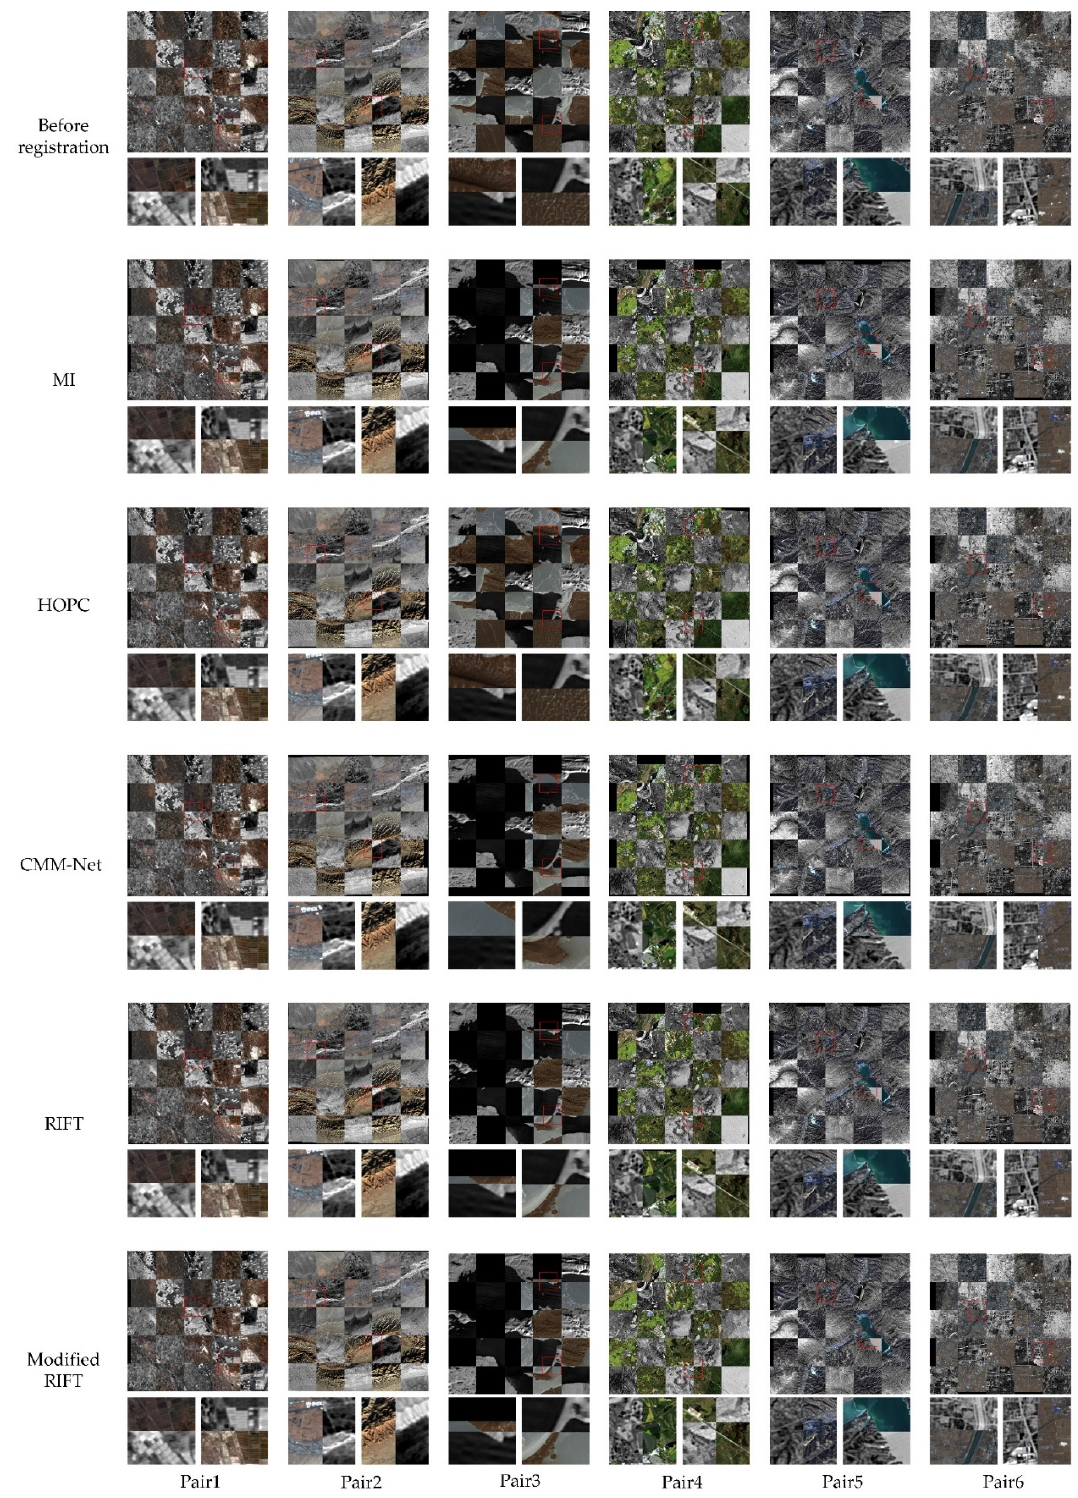
Figure 12. The chessboard image to compare the offsets before and after registration.